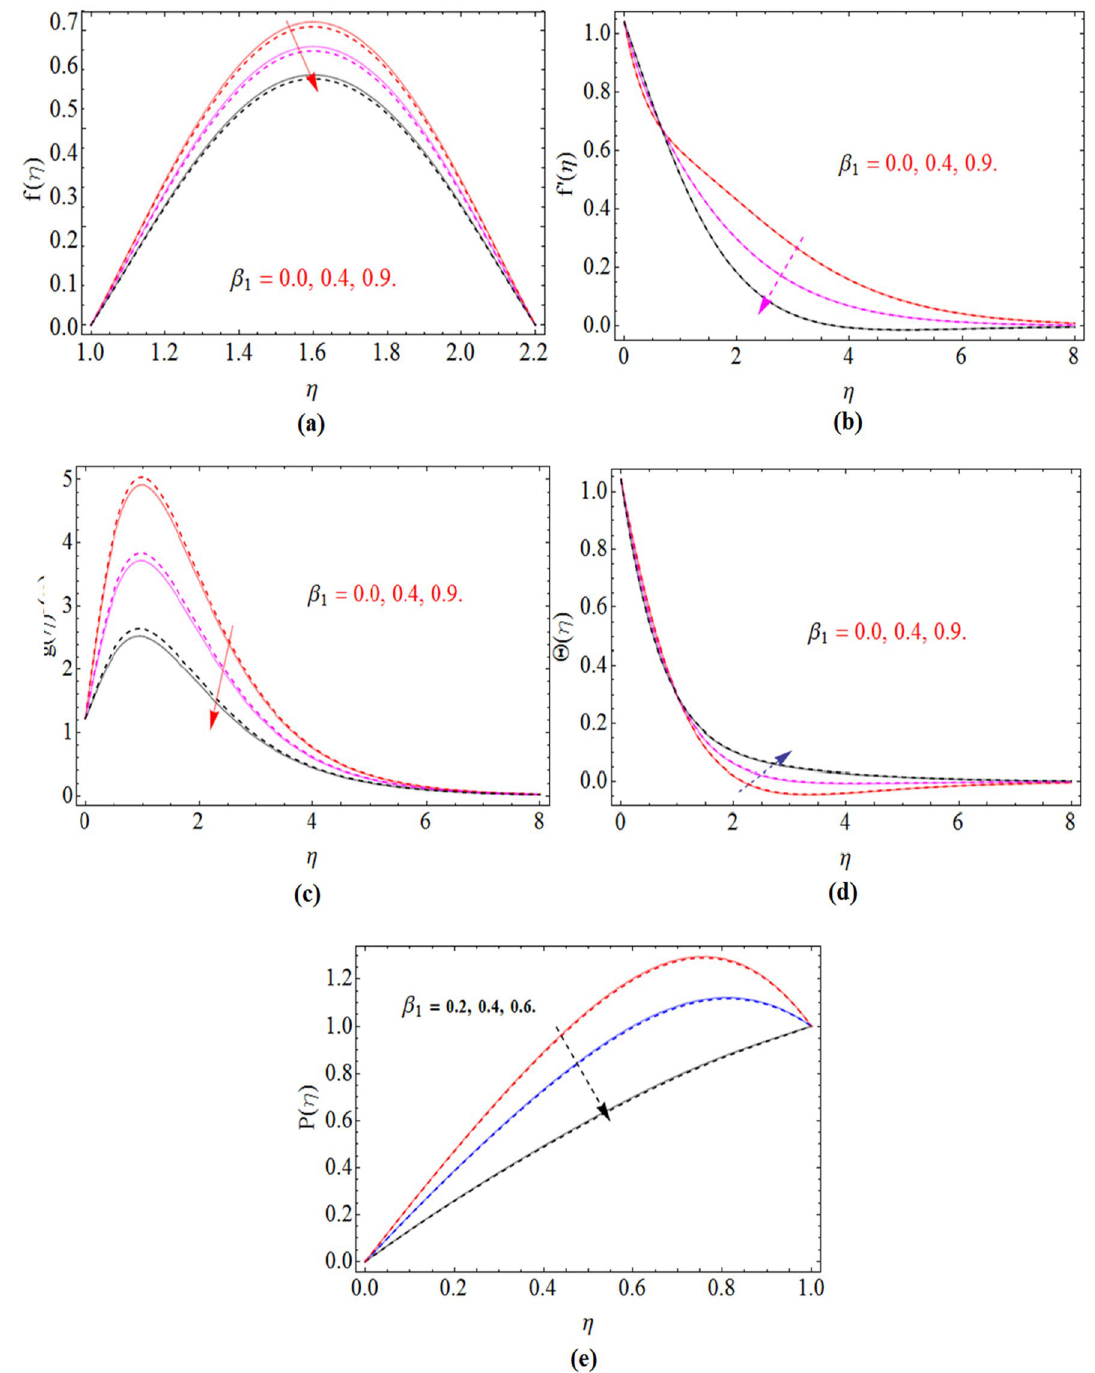
Figure 2. β 1 impact on axial f (η) , radial f ′ (η) and azimuthal velocity g (η) , temperature �(η) and pressure profile P (η) , for S 2 , when S 1 = 0.0. dashed lines for (cid:31) = 0.5 and lines for (cid:31) = −